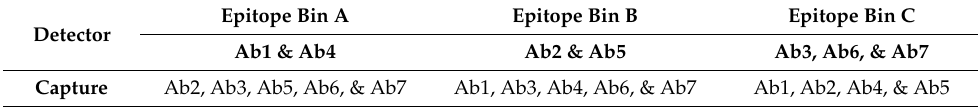
Table 1. Epitope bin and pairing